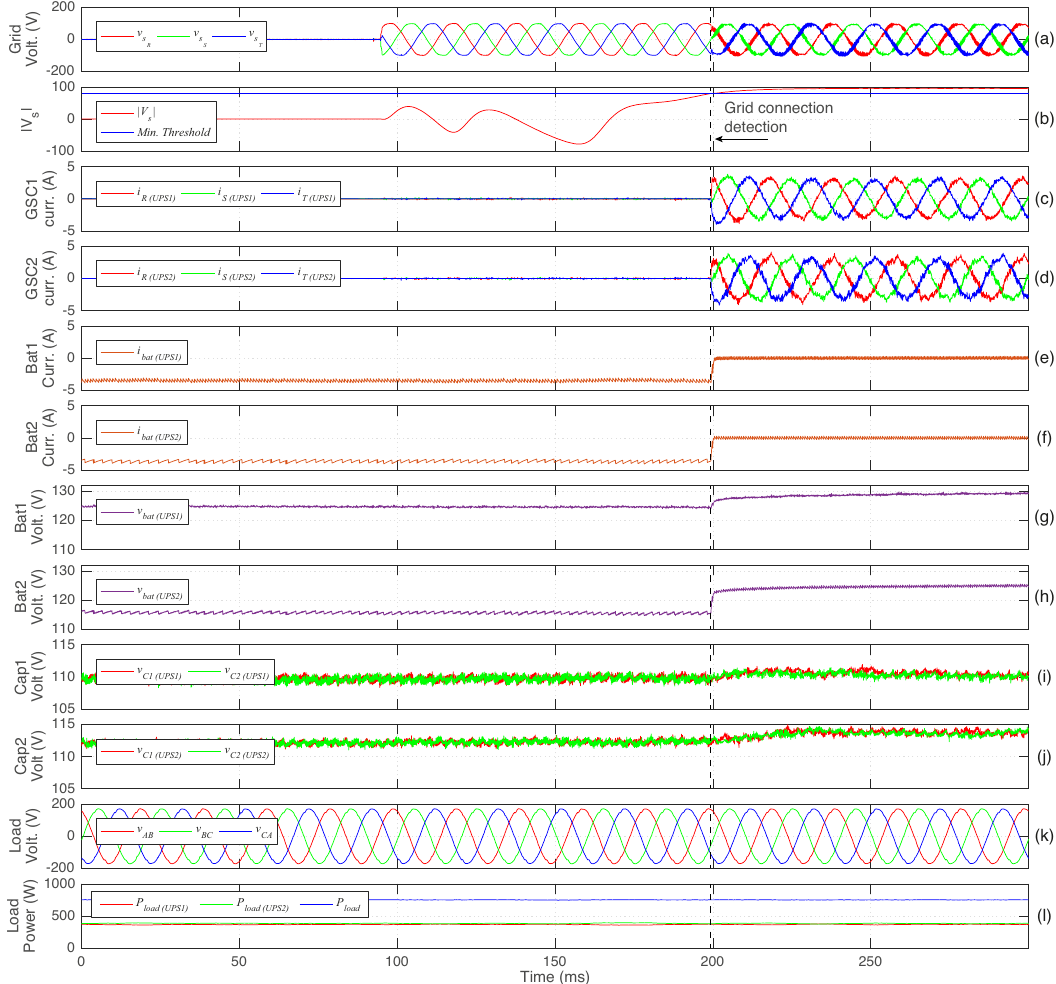
Figure 16. UPSs performance during grid connection: ( a ) Grid Voltage; ( b ) Grid voltage module; ( c ) UPS1 grid currents; ( d ) UPS2 grid currents; ( e ) UPS1 battery current; ( f ) UPS2 battery current; ( g ) UPS1 battery bank voltage; ( h ) UPS2 battery bank voltage; ( i ) DC bus capacitors voltage of UPS1; ( j ) DC bus capacitors voltage of UPS2; ( k ) Load Voltage; ( l ) Load power distribution and total load